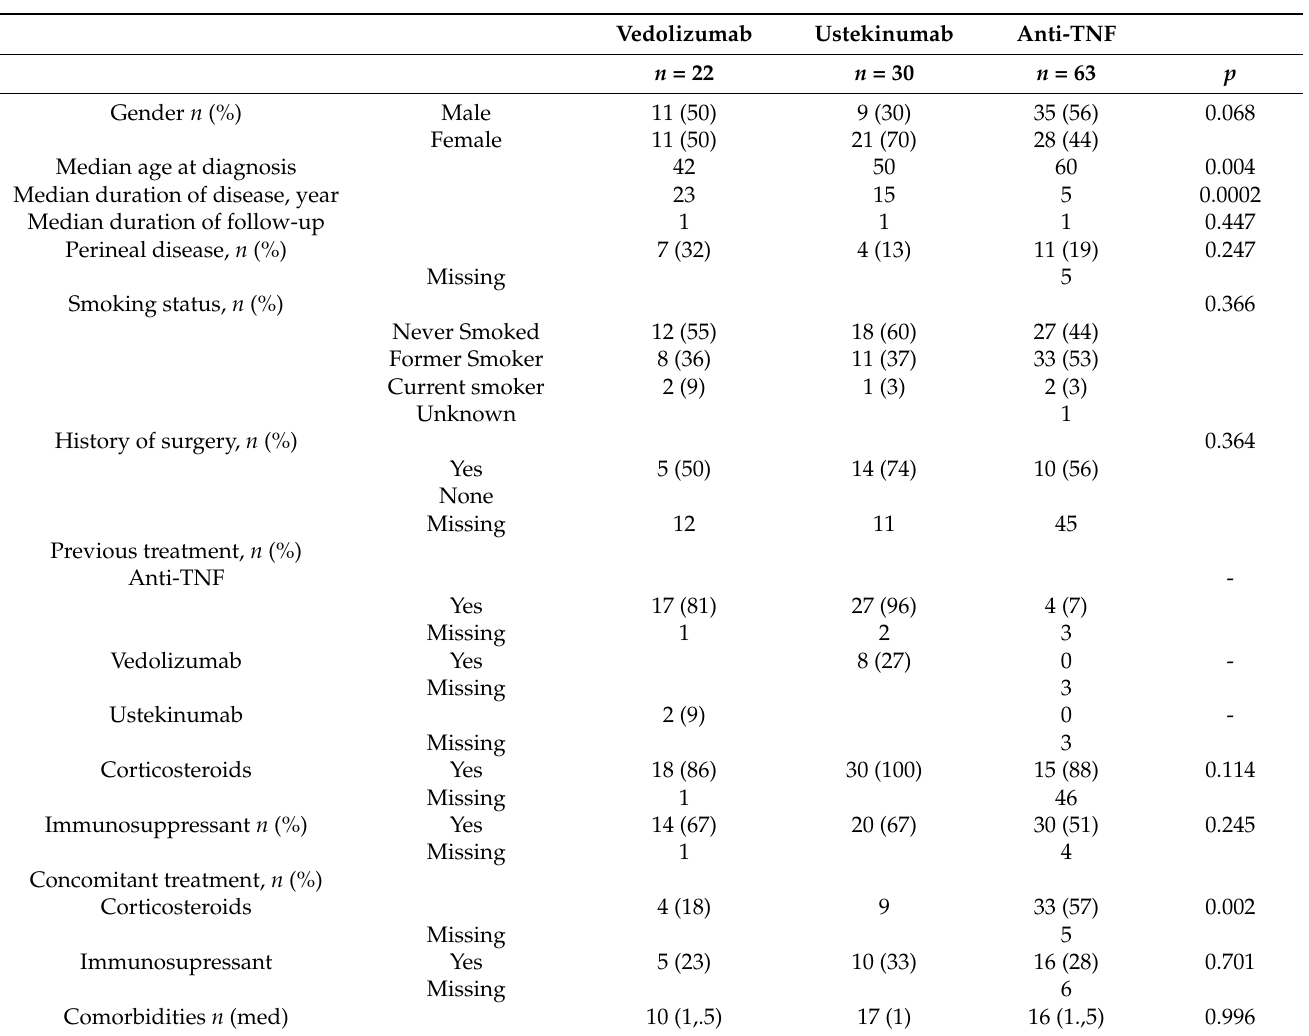
Table 1. Comparison of baseline characteristics for patients with Crohn’s disease according to